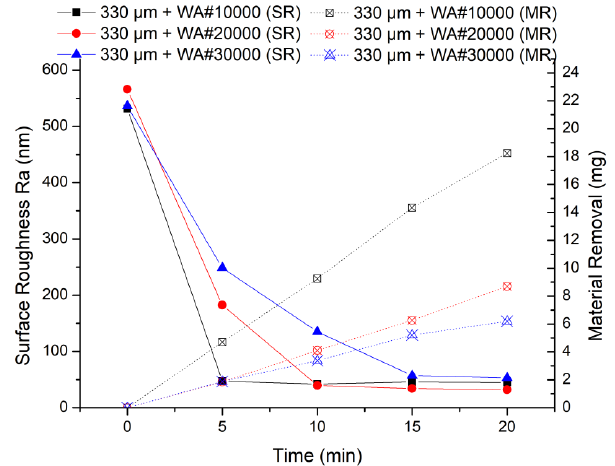
Figure 7. MAF process experimental results (330 μm electrolytic iron powder).